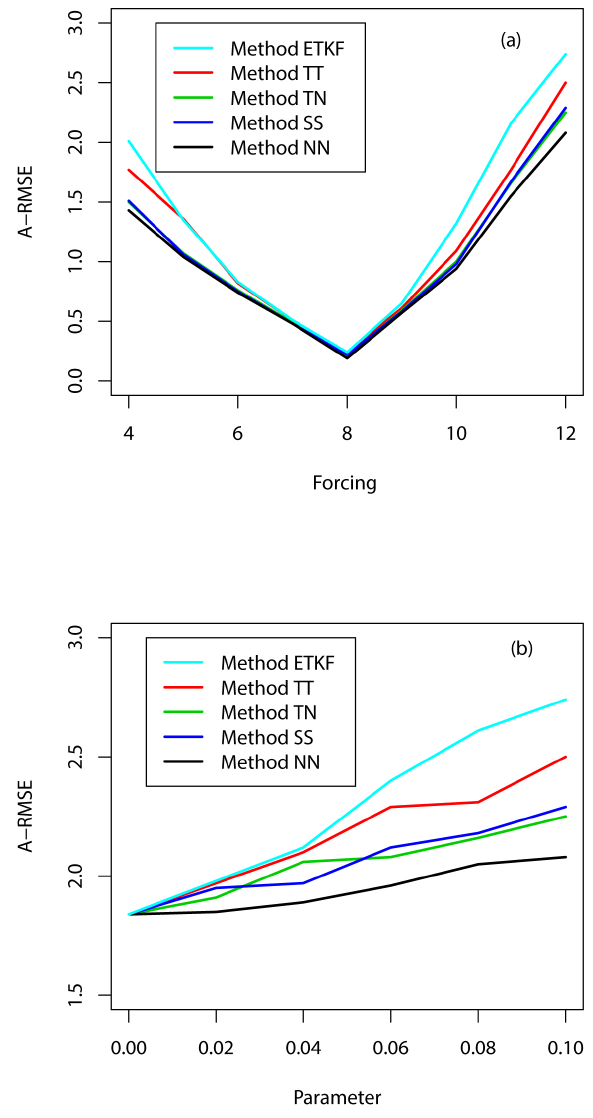
Figure 1. (a) Time-mean values of the A-RMSE as a function of forcing F for different assimilation methods in the Lorenz 96 model and the observation operator (Eq. 32) with parameter α = 0 . 1. (b) Time-mean values of the A-RMSE as a function of parameter α for different assimilation methods in the Lorenz 96 model with F = 12. ETKF: traditional ETKF in linear approximation (Eq. 12) and optimization (Eq. 10) (cyan line); TT: tangent-linear approx- imation in both inflation (Eq. 17) and optimization (Eq. 20) (red line); TN: tangent-linear approximation in inflation (Eq. 17) and nonlinearity in optimization (Eq. 10) (green line); SS: second-order Taylor approximation in both inflation (Eq. 24) and optimization (Eq. 27) (blue line); NN: nonlinearity in both inflation (Eq. 5) and optimization (Eq. 10) (black line). The ensemble size is